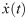
Feedback loop.The LFP is recorded from the center of the STN population and then filtered with a damped oscillator. The result is shifted through a linear delayed feedback block and is used to adjust the DBS current. The frequency of the biphasic DBS signal is adjusted linearly based on the amplitude of x˙(t). The larger the amplitude of x˙(t) is, the higher the frequency of the DBS biphasic pulses will be.